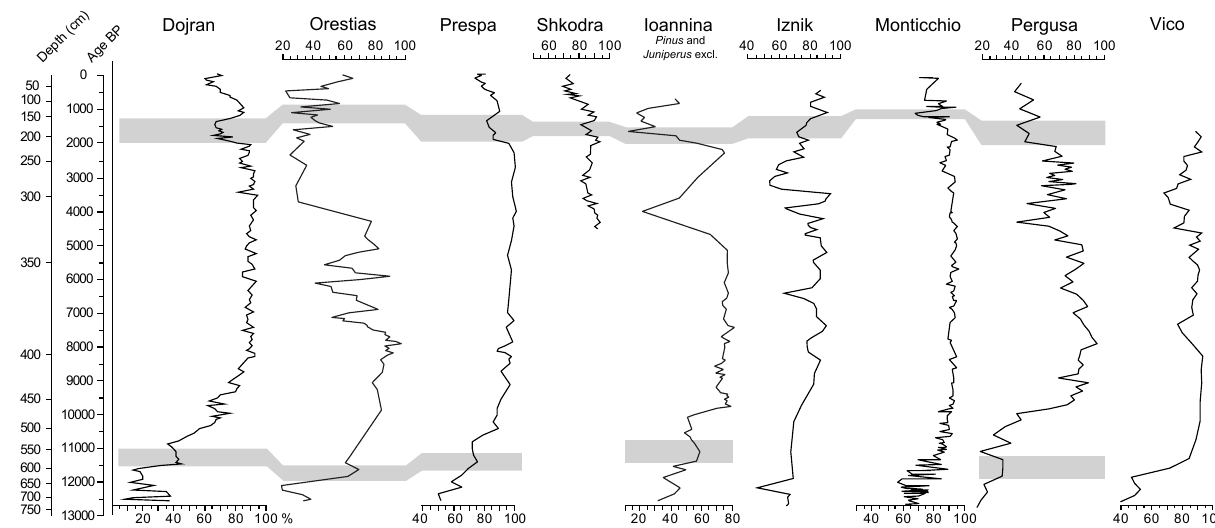
Figure 5. Arboreal pollen percentage diagram from Lake Dojran, Lake Prespa, Ioannina basin, Lake Pergusa, Lake Iznik, Lago Grande di Monticchio, Lake Vico, Orestiás and Lake Shkodra. See text for